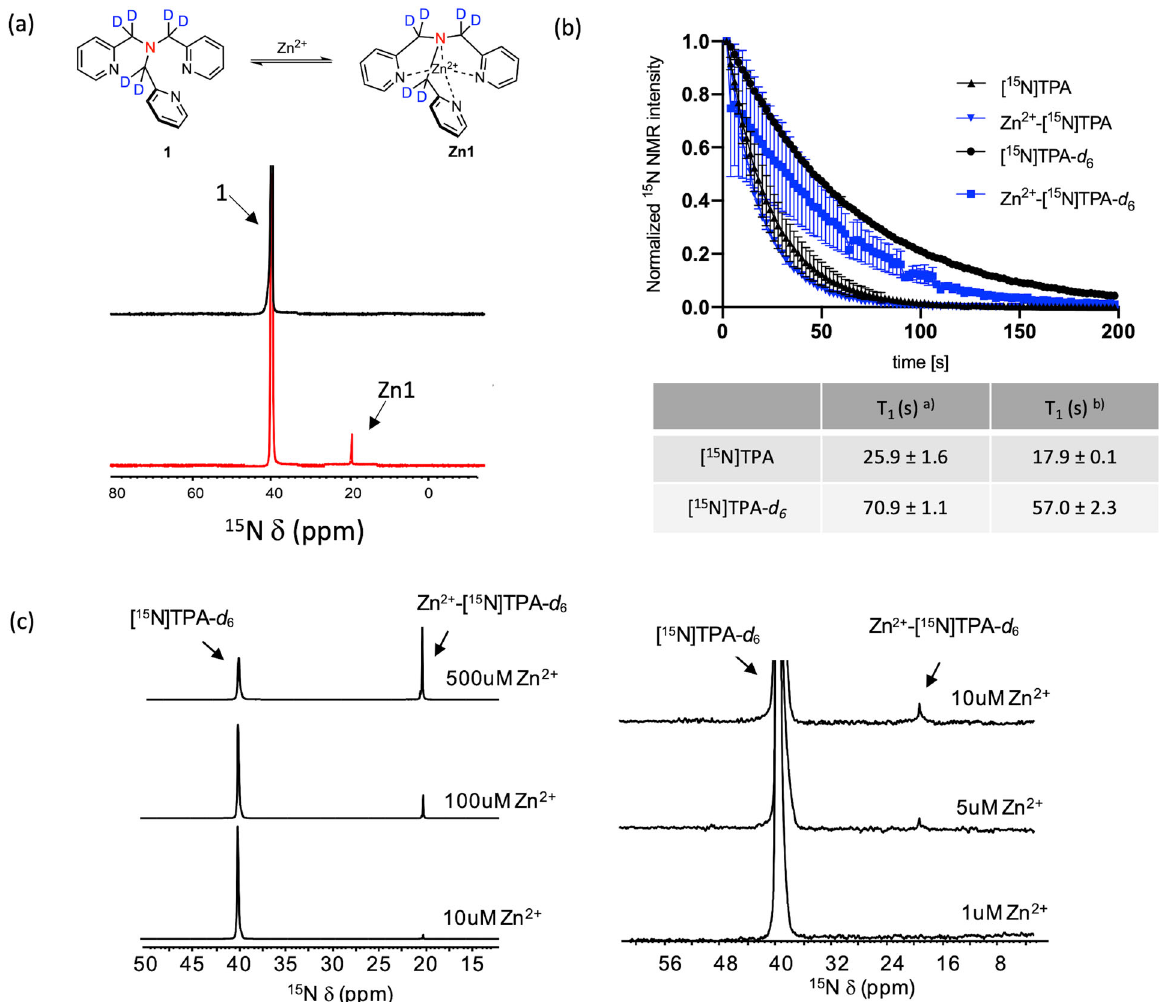
Fig. 3 DNP- 15 N MR experiments of [ 15 N]TPA derivatives. a 15 N NMR chemical shift of [ 15 N]TPA- d 6 in the absence and presence of Zn 2 + (0.25 eq). b Sequential [ 15 N]TPA and [ 15 N]TPA- d 6 spectrum decay and T 1 relaxation of free ligand a) and Zn 2 + complexes b) measured at 9.4 T, 298 K, pH